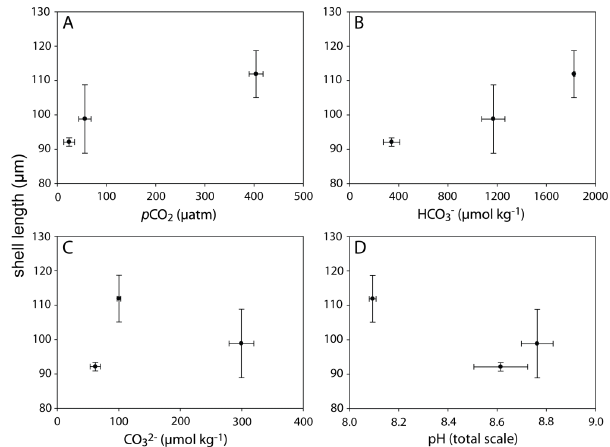
Figure 2. Exp. 2 Calcification response (measured as shell length) of M. edulis larvae kept under modified carbonate chemistry con- ditions for four days during the lecithotrophic phase. Shell length is plotted against seawater (a) p CO 2 , (b) [HCO − (d) pH. Data represent mean ± SD.